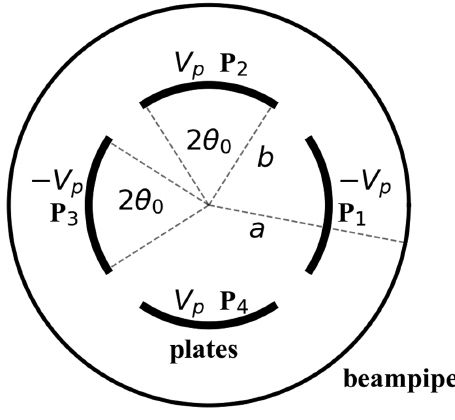
FIG. 2. Quadrupole kicker plates along the arc of a